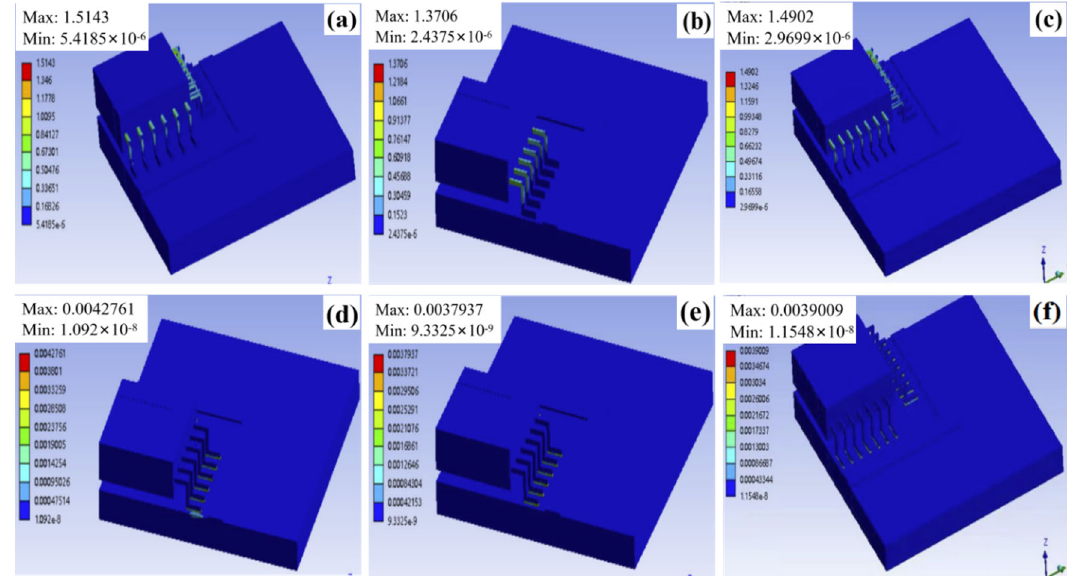
Figure 8. FEM analysis of stress ( a – c ) and strain ( d – f ) analysis of QFP48 electronic packaging subjected to TC: 4 × 12, SAC105: ( a , d ); 4 × 12, SAC105 ‐ (nano)Al 2 O 3 /Cu: ( b , e ); 4 × 14, SAC105 ‐ (nano)Al 2 O 3 /Cu: ( c , f ).